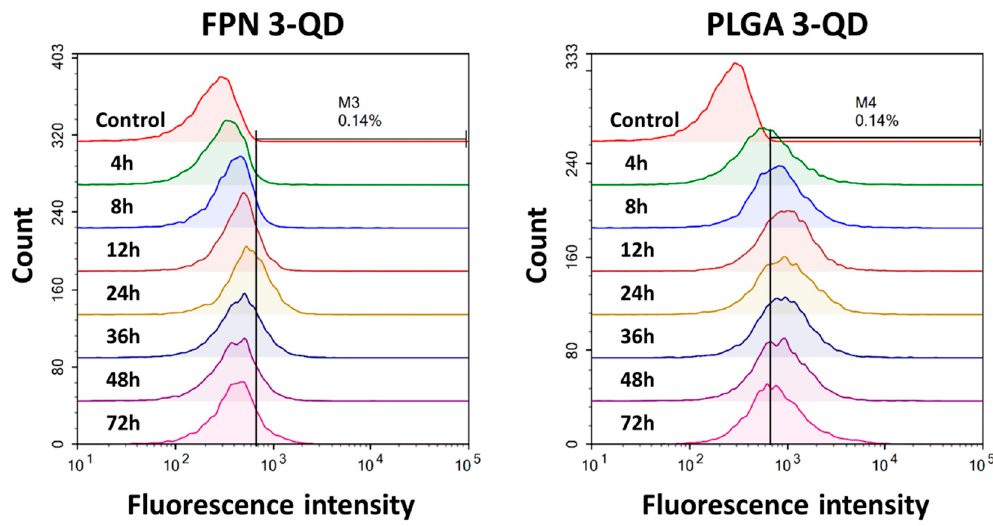
Figure 6. ( a ) Fluorescence images of cellular uptake of quantum dot-loaded FPN (FPN 3-QD) and ( b ) quantum dot-loaded PLGA particles (PLGA 3-QD) by MDA-MB-231 breast cancer cells at different times after feeding FPN 3-QD or PLGA 3-QD. Blue is DAPI for labeling the nuclei, green is phalloidin for labeling the cytoskeleton (F-actin), and red is the quantum dot from FPN 3-QD or PLGA 3-QD. (Scale bar: 20 μ m).